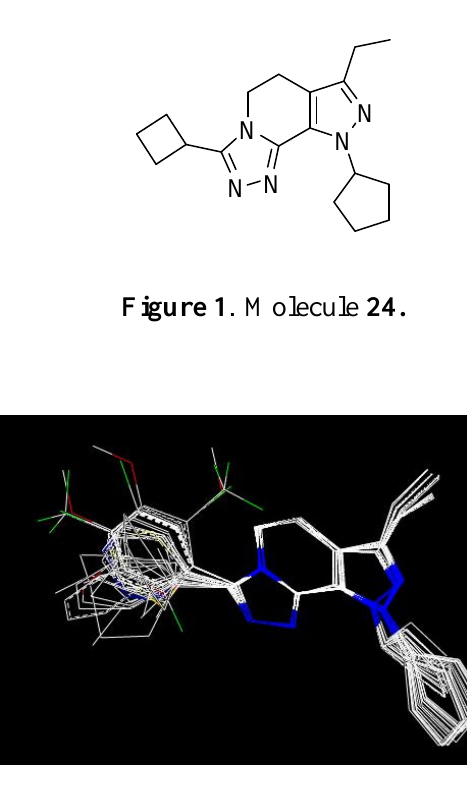
Figure 2 . Alignment of the compounds used in the training set of 3D-QSAR